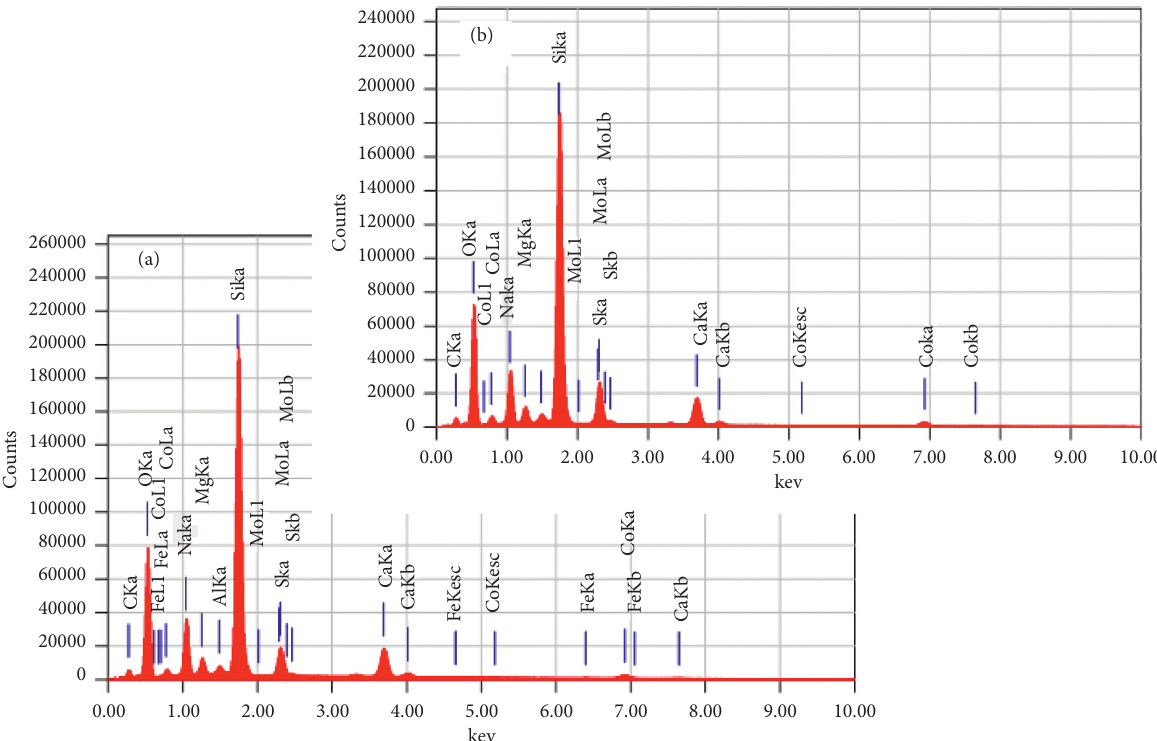
Figure 3: EDX spectra of cobalt sulfide thin films deposited at (a) 2 hours and (b) 3 hours.